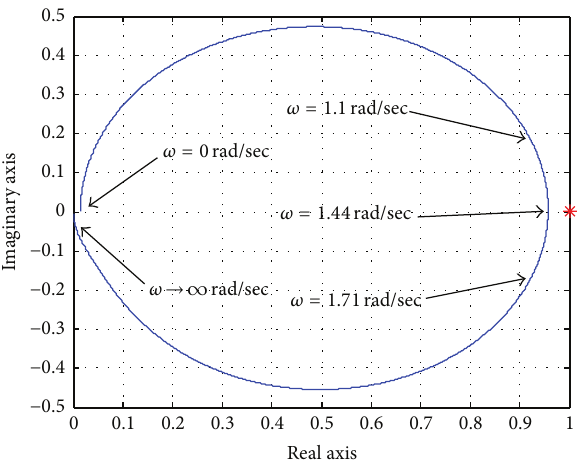
Figure 11: Nyquist plot of 𝛾 3 (𝑠) (Case 3